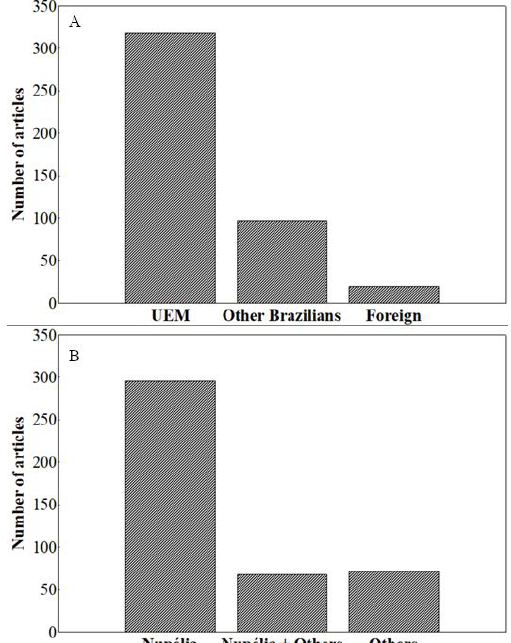
Figure 3. A) Number of articles published by